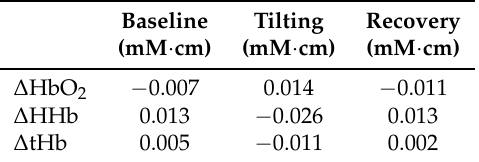
Table 2. Mean absolute errors (MAE) between haemoglobin concentrations estimated from the two PPG sensors during the bed tilting protocol. Baseline Tilting